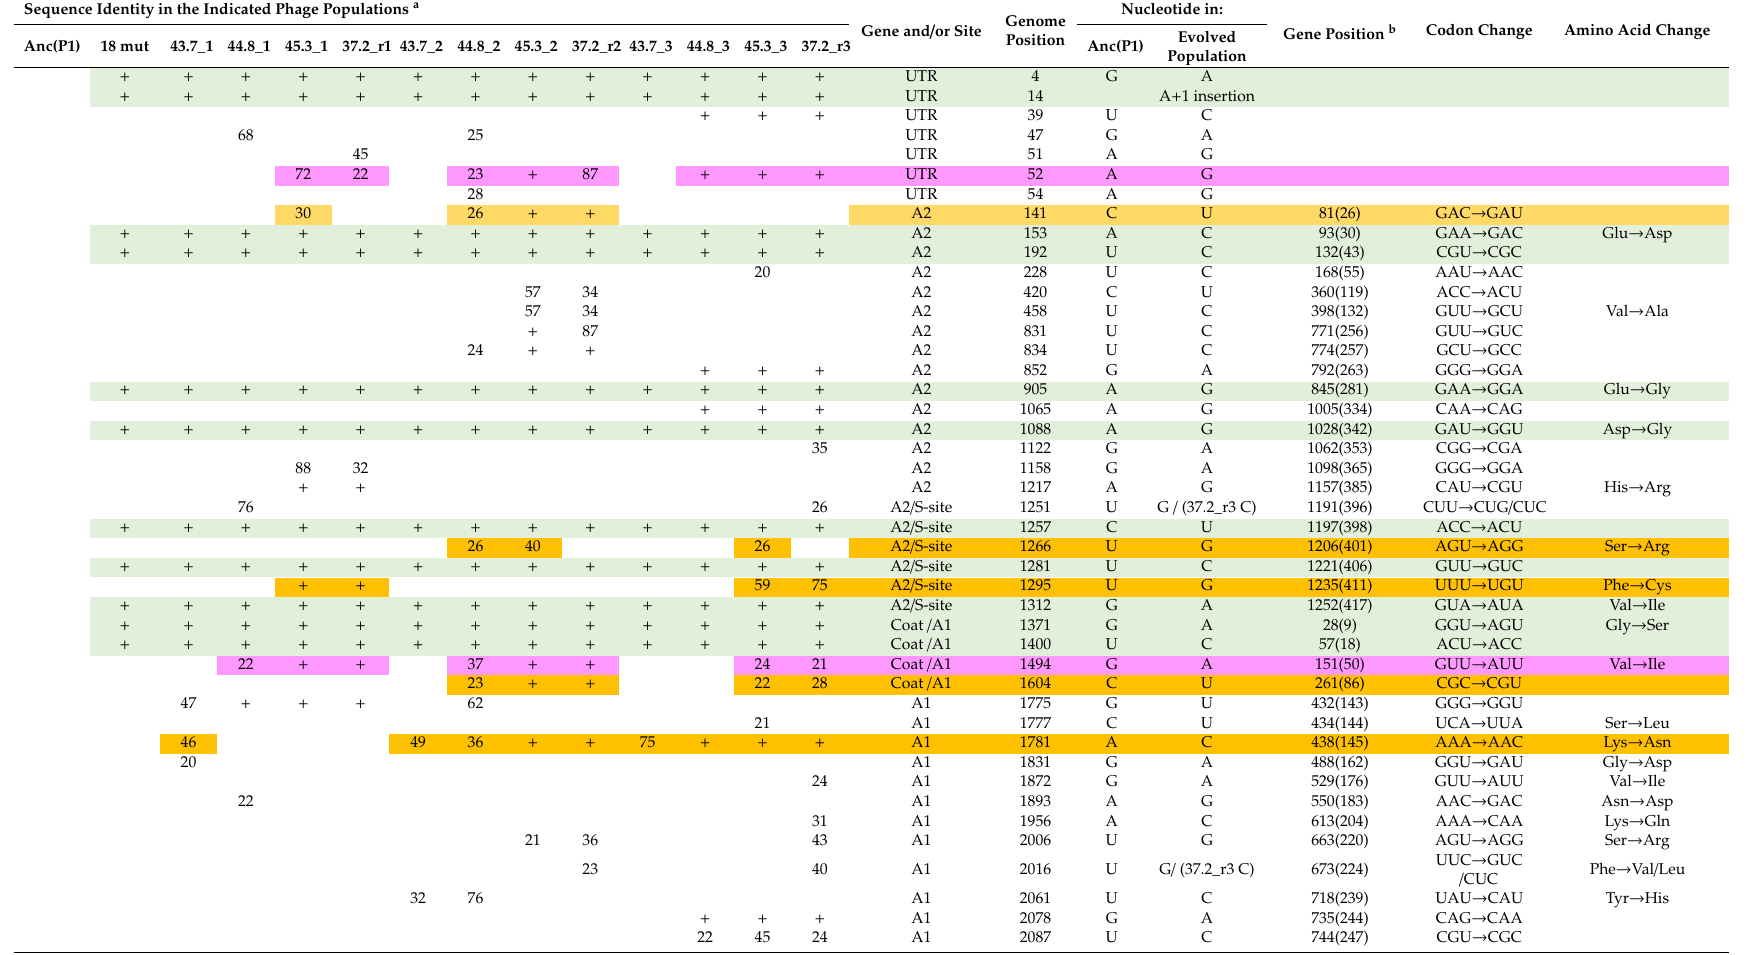
Table 1. Nucleotide sequences of the Anc(P1), 18 mut and evolved phage